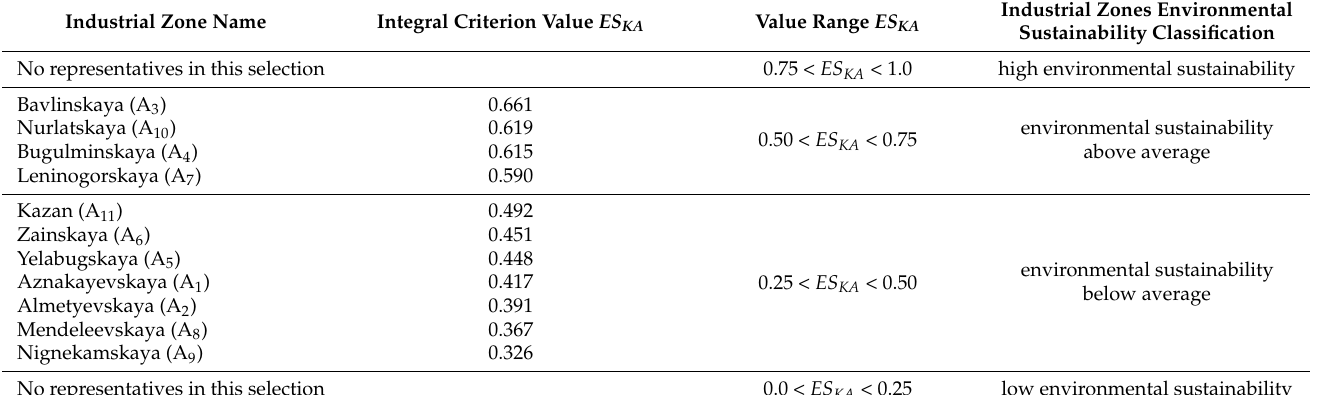
Table 3. Additive global criterion value for ES KA environmental sustainability and industrial zones